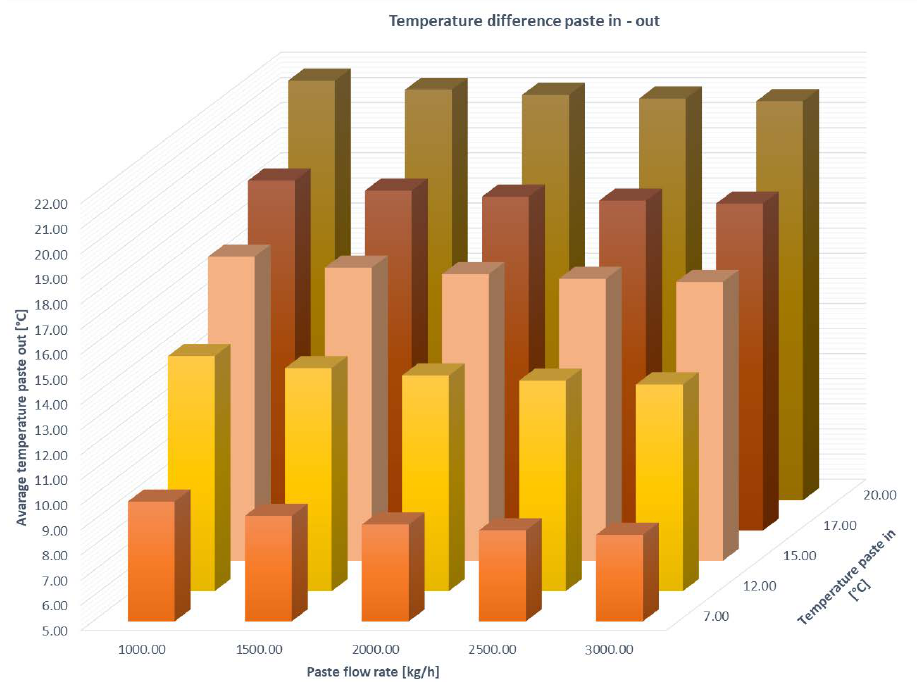
Figure 4. Average values of temperature paste at the outlet of inner tube.